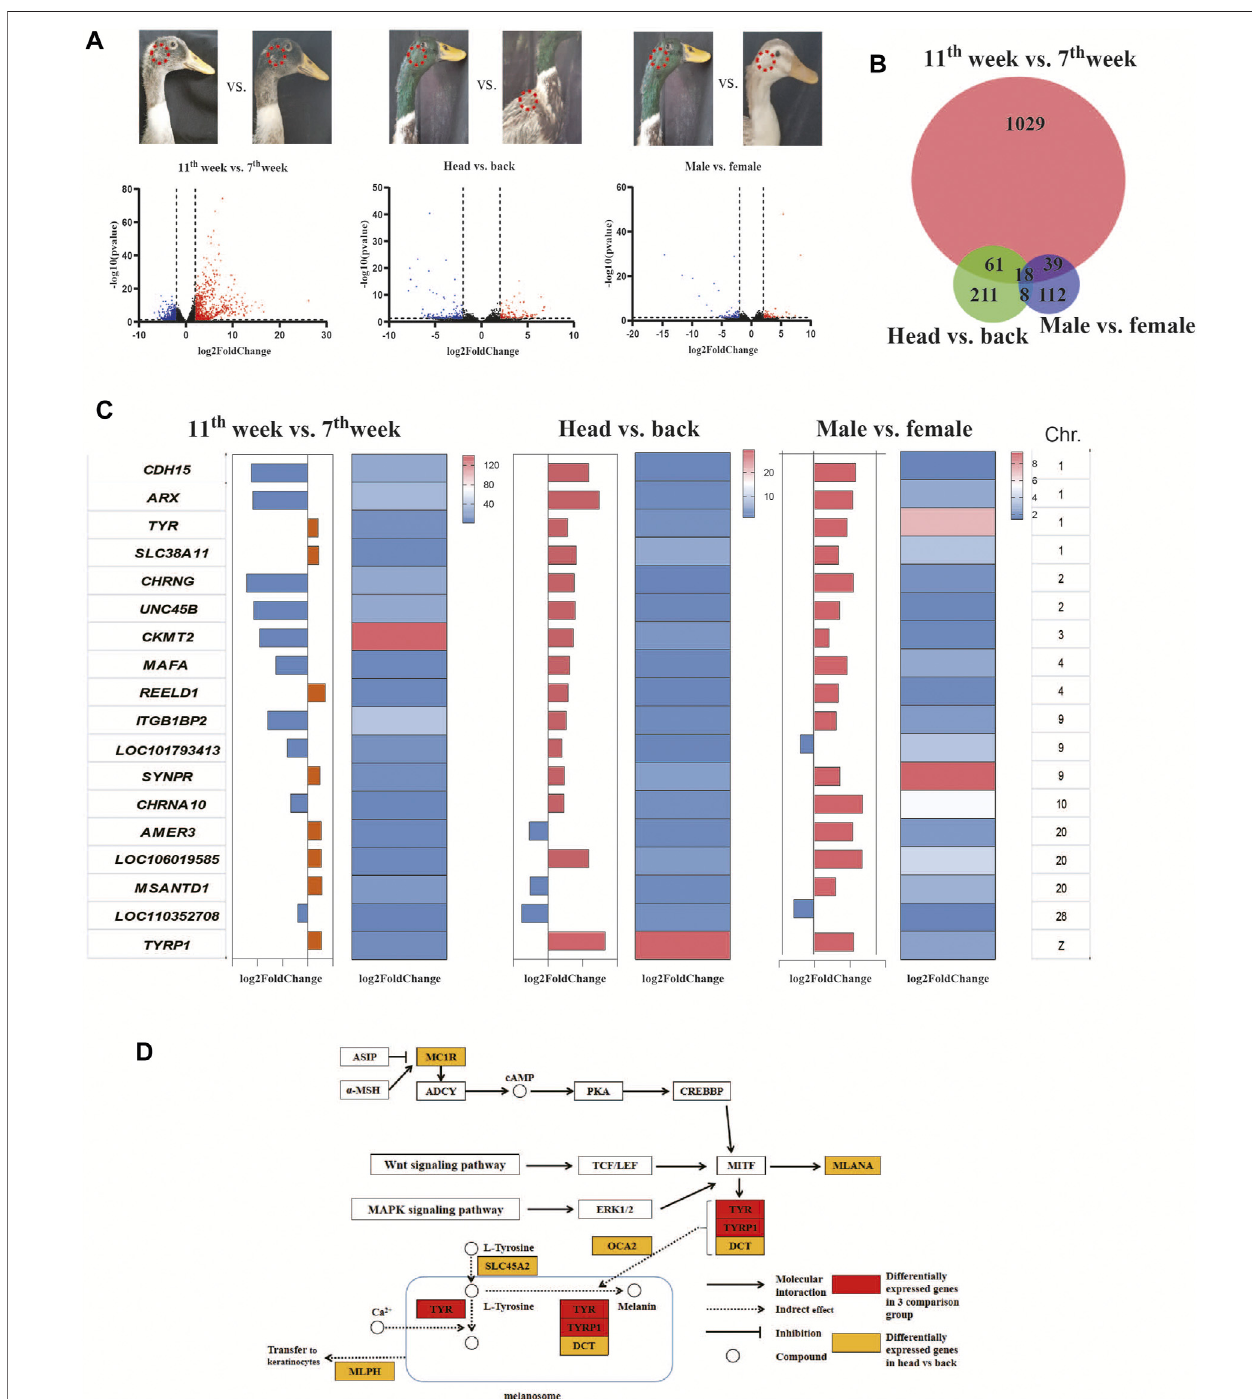
FIGURE3| Screeningofthecausativegenesofthemalegreenheadfeathers. (A) Volcanoplotsshowingthedifferentiallyexpressedgenes(DEGs)of3comparison pairs: 11w vs. sevenw,male vs. female,andhead vs. back.Wehaveindicatedthesamplingpointsineachimageofamallard. (B) TheVenndiagramshowsthenumber ofDEGsamongthethreecomparisongroups. (C) Theconsensusgenesweredifferentiallyexpressedamongthethreecomparisongroups. (D) Thesignalingpathwayof melanin biosynthesis.